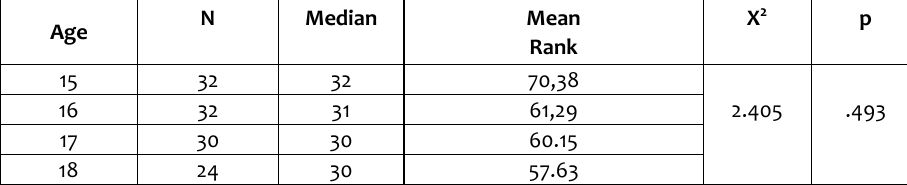
Table 3. Comparison of the Level of Socialization According to the Ages of Obese Youth Attended in the Study with the Mann-Whitney U Test